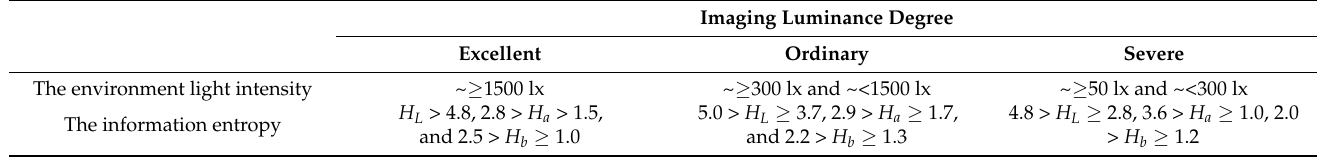
Table 2. Definitions of imaging luminance